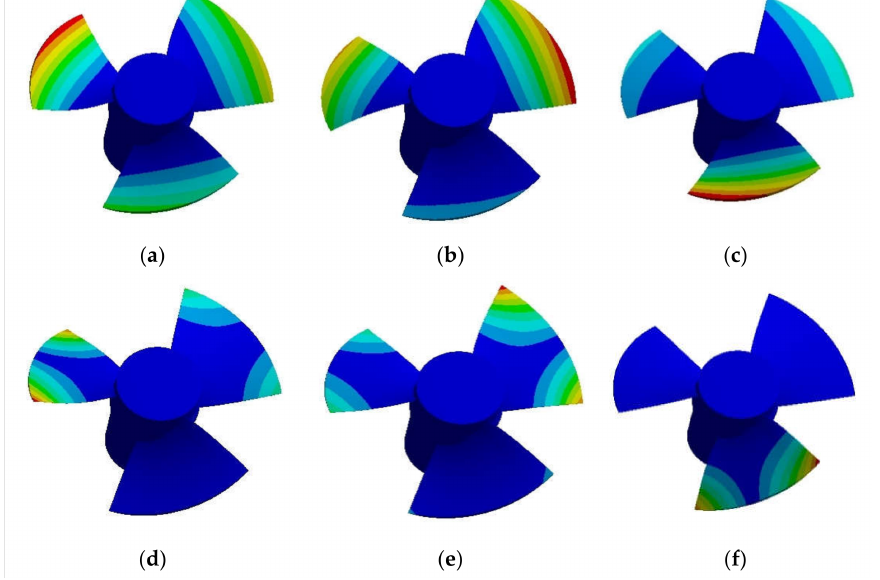
Figure 22. The mode shape changes of scheme II in each order mode. ( a ) First-order mode. ( b ) Second- order mode. ( c ) Third-order mode. ( d ) Fourth-order mode. ( e ) Fifth-order mode. ( f ) Sixth-order